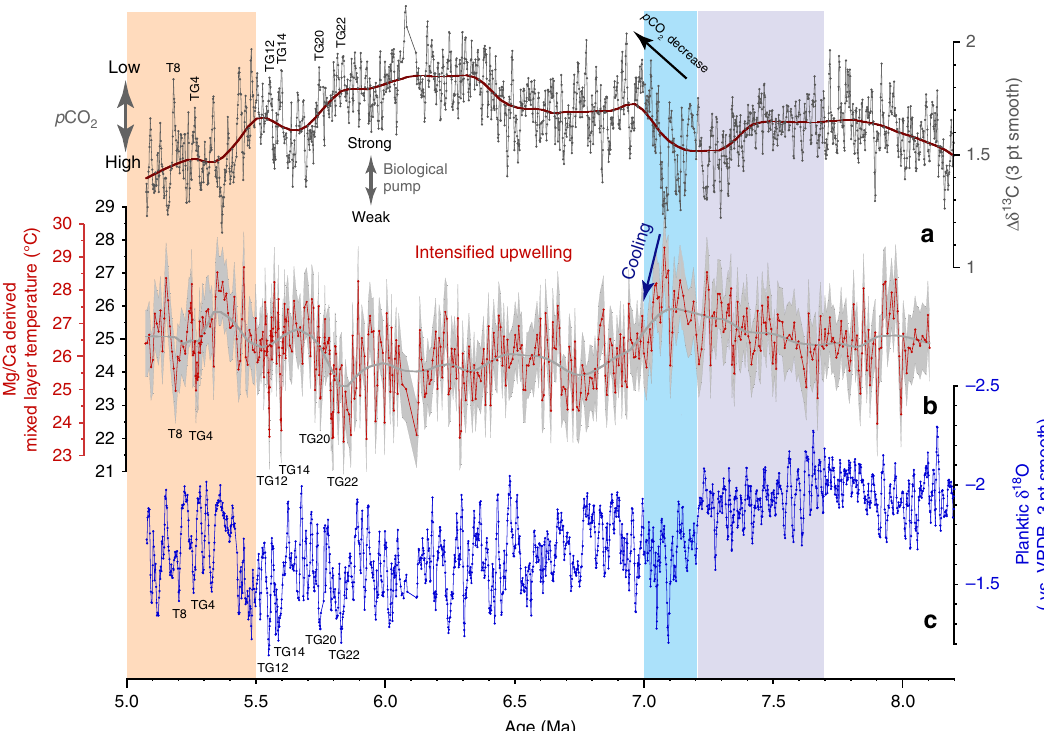
Fig. 3 Evolution of mixed layer hydrology and productivity at ODP Site 1146. Steepening of Δ δ 13 C in conjunction with cooler temperatures and heavier planktic δ 18 O between ~7 and 5.5 Ma denote p CO 2 decrease associated with enhanced carbon sequestration fl ux and intensi fi cation of Asian winter monsoon. a Gradient between planktic and benthic foraminiferal δ 13 C. b Mixed layer Mg/Ca-derived temperatures with (red scale) and without (black scale) correction for secular changes in Mg/Ca of seawater. Calculation of error envelope follows ref. 72 . Brown smooth curve in a and gray smooth curve in b fi tted using locally weighted least squared error (Lowess) method. c Planktic foraminiferal δ 18 O; 3 pt smooth: 3 pt moving mean. Lilac shading marks global δ 13 C decline coincident with planktic δ 18 O increase and high-amplitude obliquity modulation of benthic δ 18 O. Blue shading marks fi nal stage of global δ 13 C decline. Light orange shading marks climate warming after 5.5